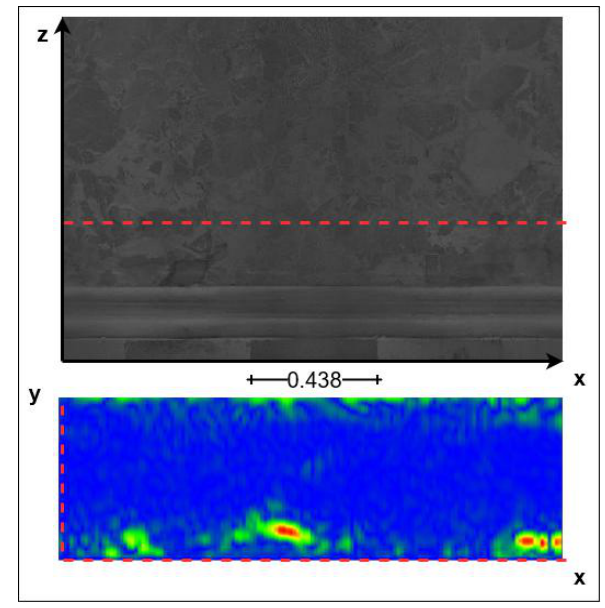
Figure 10. NIR developed photogrammetry-produced orthophoto of the lower left column and GPR slice of the column at h = 0.619 m from the floor (main